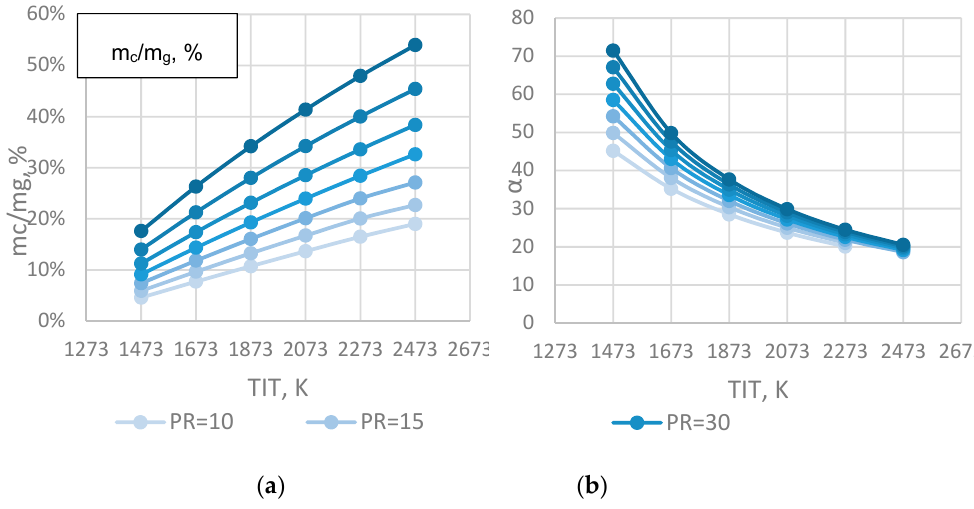
Figure 6. Cooling mass flow rates vs. ( a ) air to fuel ratio ( b ) TIT, for different PR.